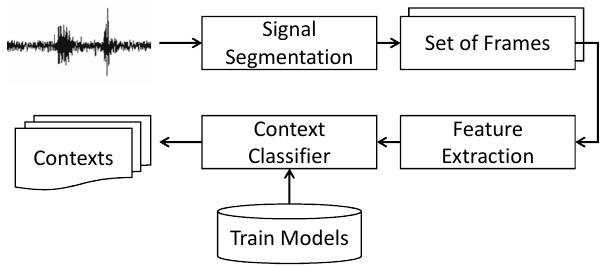
Figure 4. Real-time mining of users’